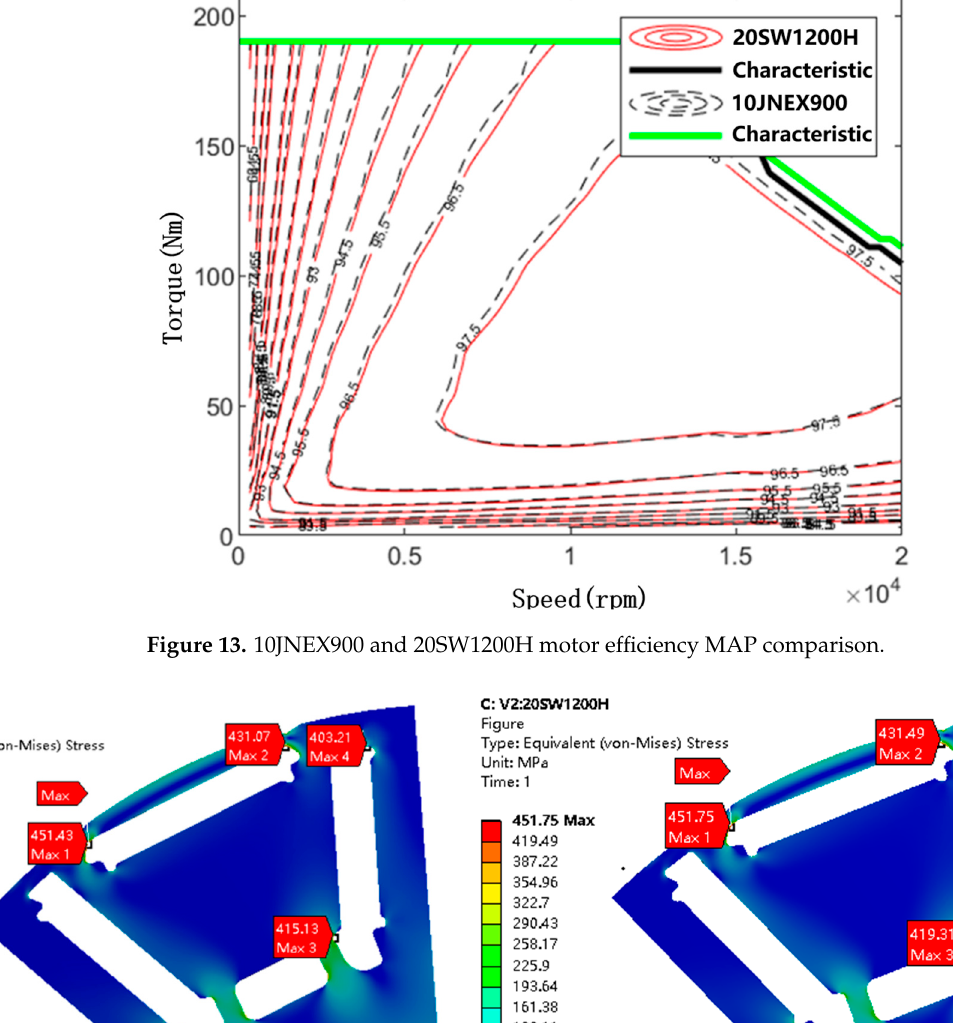
Figure 13. 10JNEX900 and 20SW1200H motor efficiency MAP comparison.